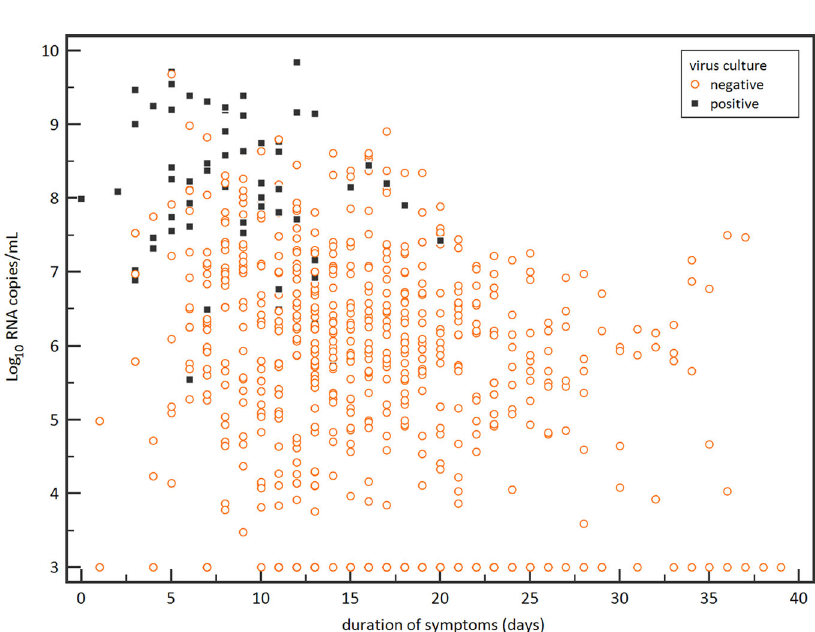
Fig. 1 Viral loads and duration of symptoms for infectious virus shedding. Viral RNA loads (Log 10 RNA copies/mL) in the respiratory samples versus the duration of symptoms (days). Black boxes represent virus culture positive samples and open red circles represent the virus culture negative